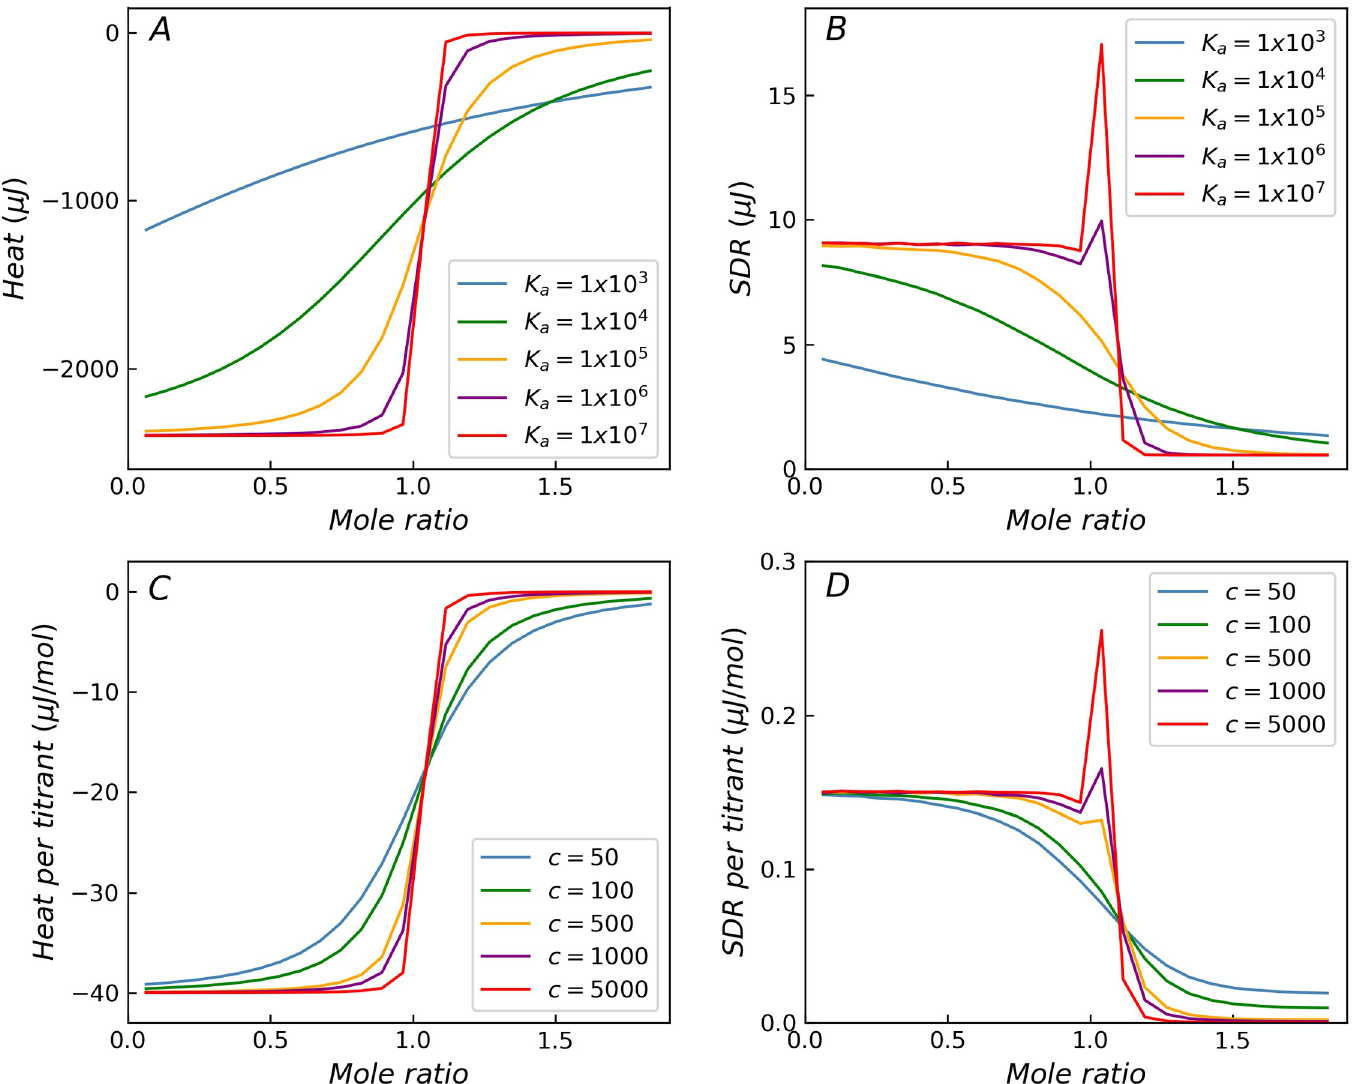
Fig 2. The influence of K and c -values on the distribution of SDR. Theoretical titration curves and SDR for simulated reactions with different K a D). With the increase of K a or c -value, the SDR increases significantly in the transition region (B,